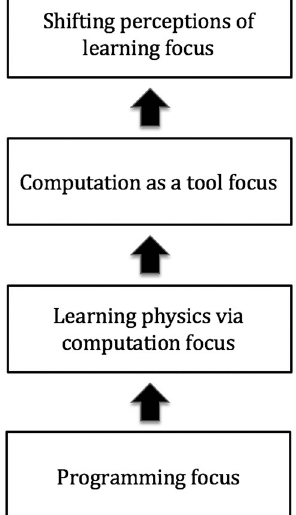
FIG. 1. Outcome space indicating the structure relating the identified learning assistant approaches to teaching computa- tional